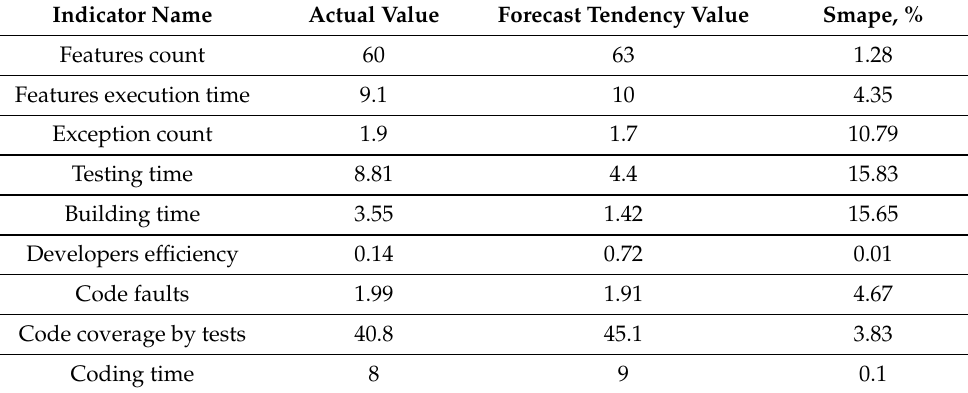
Table 3. Forecasts of indicators of development.